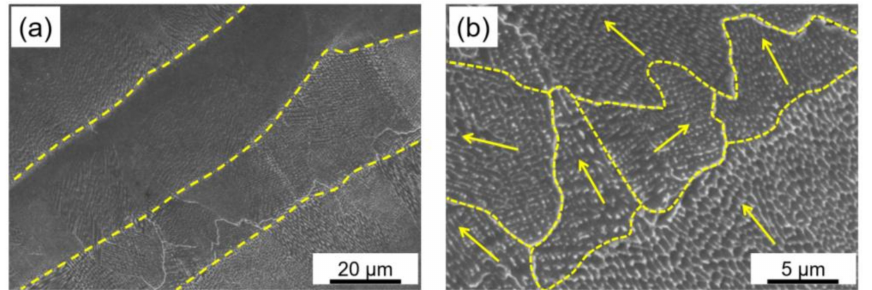
Figure 9. SEM micrographs of as-built sample parallel to the building direction; ( a ) SEM image in low magnification shows columnar/cellular structure in successive layers; ( b ) grains and colum- nar/cellular sub-grains (arrows in ( b ) indicate dendrite growth